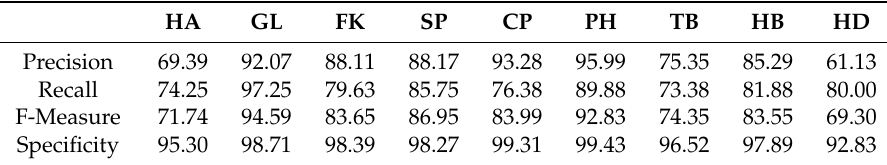
Table A3. Values of precision, recall, F-Measure, specificity of LOSO model SVM I (all values are expressed in %).